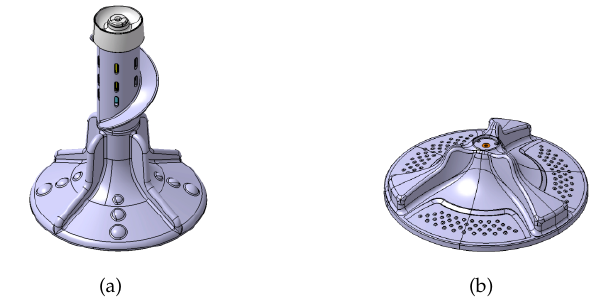
Figure 4. Traditional agitator ( a ) and low profile agitator ( b ): Image provided by Electrolux. VA-WM Washing Cycle